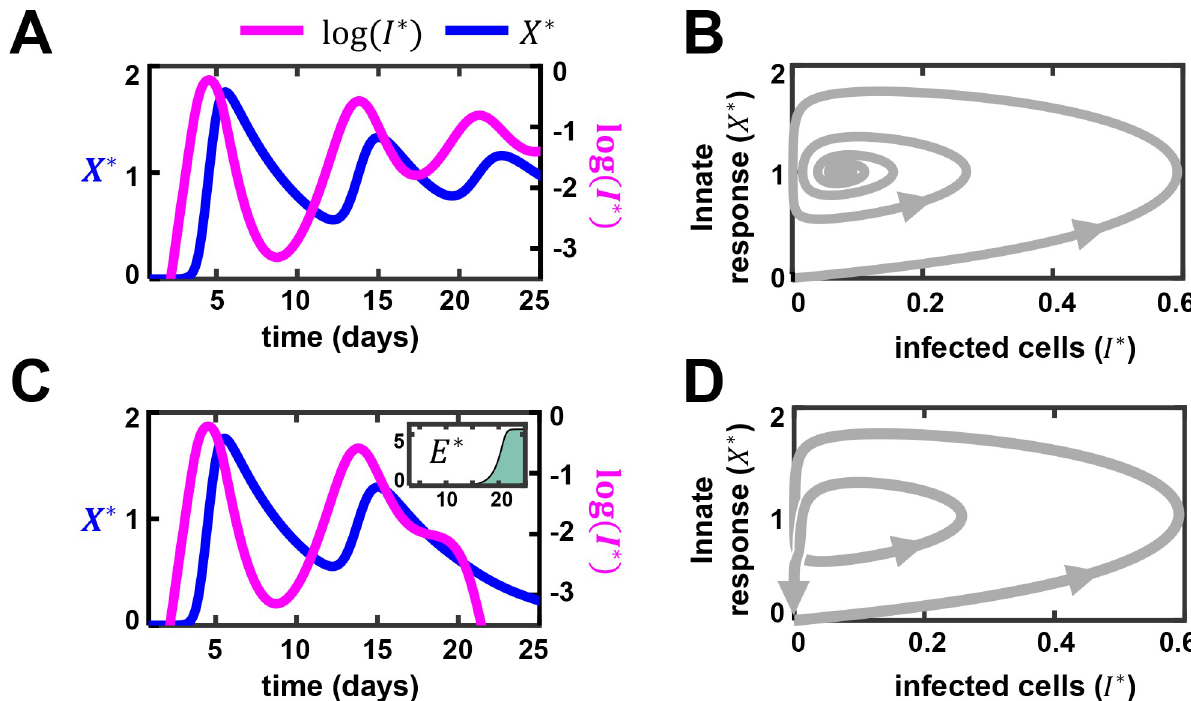
Fig 3. Predator-prey-like oscillations may underlie multiple viral load peaks. (A) The dynamics of infected cells ( I ) and innate immune response ( X ) in the absence of CD8 T-cells ( E ). The asterisk represents rescaled variables (see Methods). (B) Corresponding trajectory on a phase plane plot of infected cells and innate response. (C) and (D) Predictions as in (A) and (B) but in the presence of E . Inset shows the dynamics of E over time (in days). The individual parameters for patient id 10 (Table 3) were used. Parameter values used are as the following: k 1 = 4.41/day, k 3 = 0.73/day, ¼ 2 : 64 /day, k � ¼ 8 : 93 � 10 (cid:0) 4 ; τ = 0.88 day, k 6 = 0.2/day, k 4 = 1.5/day, k � ¼ 0 : 7 ; α = 1.0 × 10 4 , β = 2.0 × 10 4 /day, γ = 0.5/day. In (A) and (B), we set k � 5 p e ¼ 0 whereas in (C) and (D), we let E � = 6.42 × 10 − 3 E � 0 0